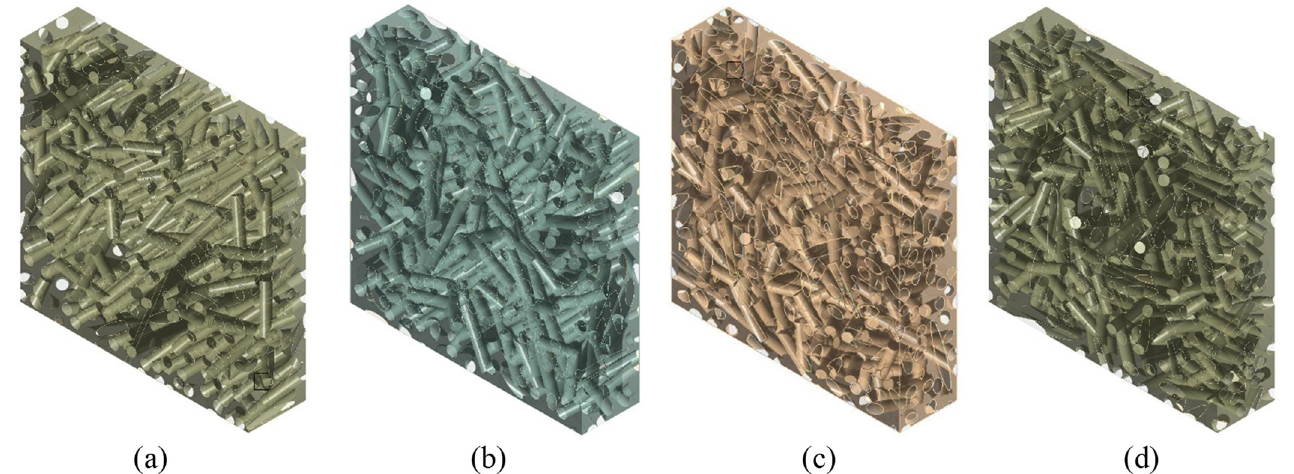
Figure 10. RVE of epoxy resin-short sisal fiber composites with V f = 0.35 and variable orientation distribution: ( a ) dx = dy = dz = 0.33, ( b ) dx = dy = 0.35 and dz = 0.3, ( c ) dx = dy = 0.375 and dz = 0.25, ( d ) dx = dy = 0.4 and dz = 0.2.